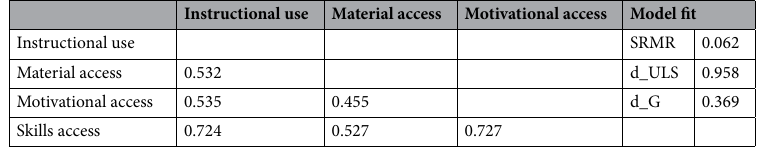
Table 4. HTMT ratio and model fit.